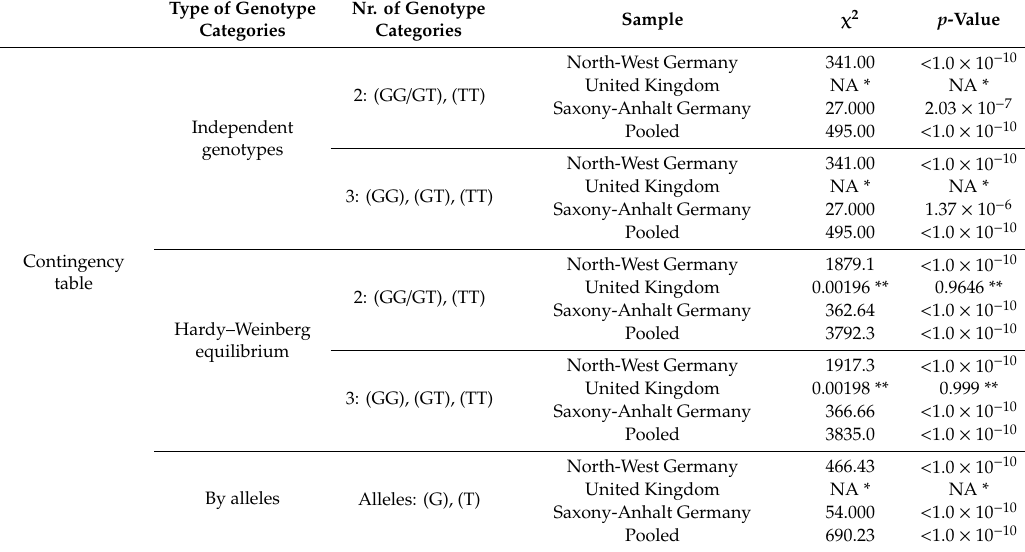
Table 4. Tests of randomness of genotype and phenotype frequencies. Multinomial and contingency table tests were carried out for di ff erent types of categories for genotypes, for each geographical sample, and with two or three genotype categories. As we tested associations with two phenotypes hypothesized to be caused by two genotype categories, a two genotype categories test was statistically justified. NA means that the test was not able to be computed, generally because of mathematical obstacles (e.g., a division by